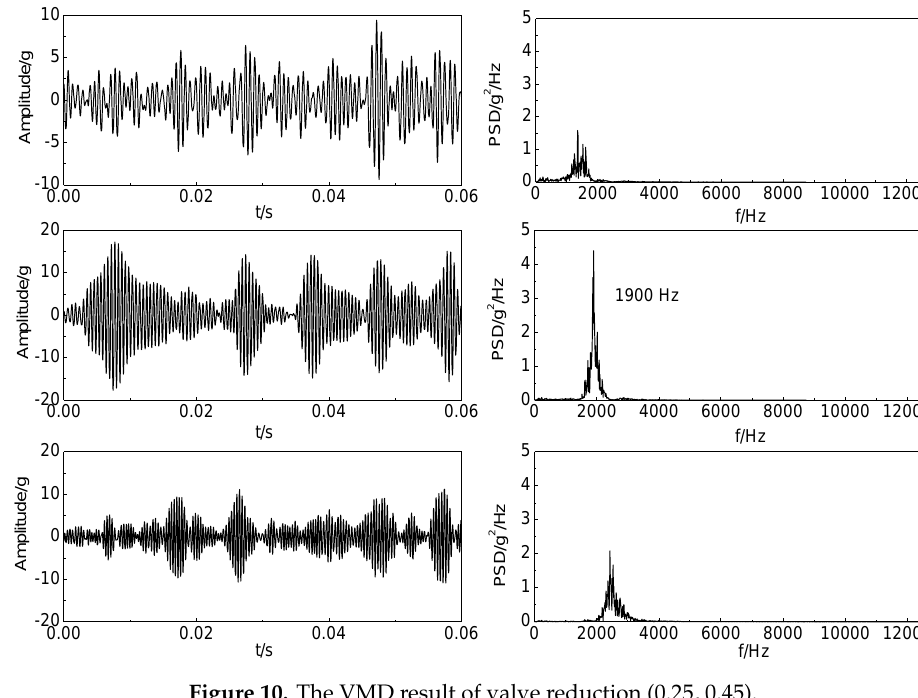
Figure 10. The VMD result of valve reduction (0.25, 0.45).